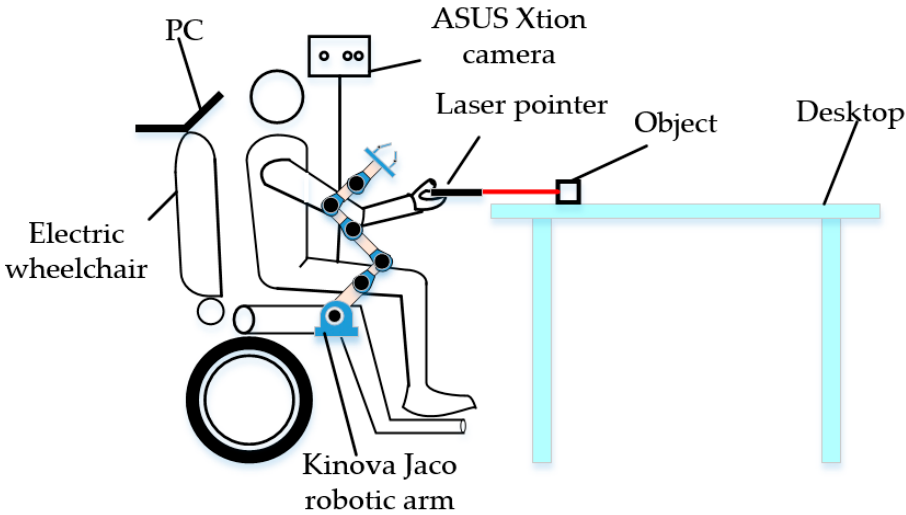
Figure 1. Diagram of experimental platform.